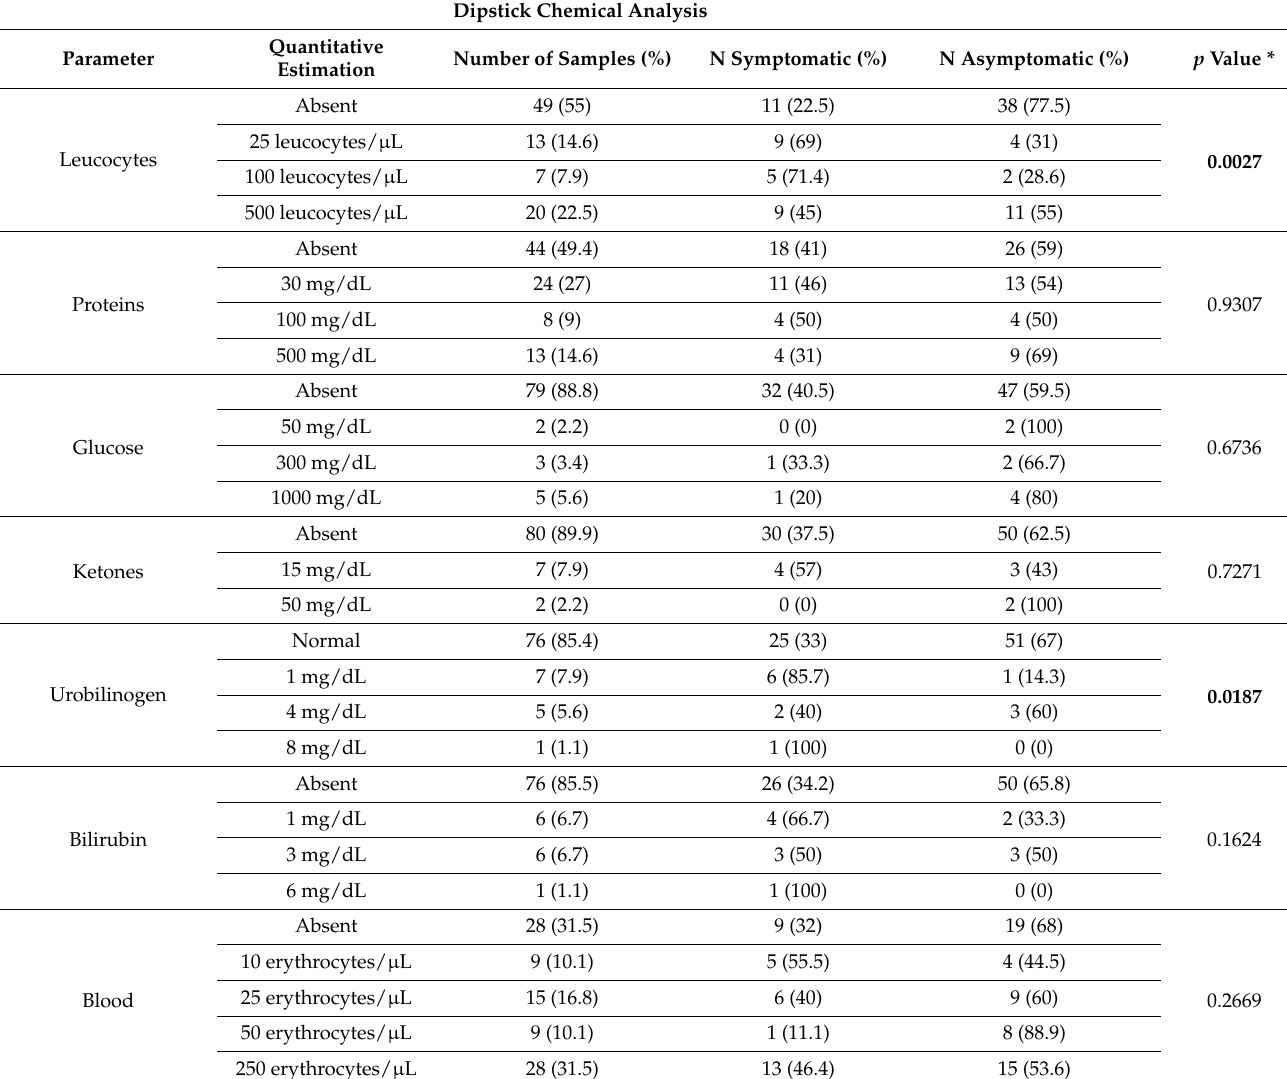
Table 1. Chemical urinalysis results (Dipstick